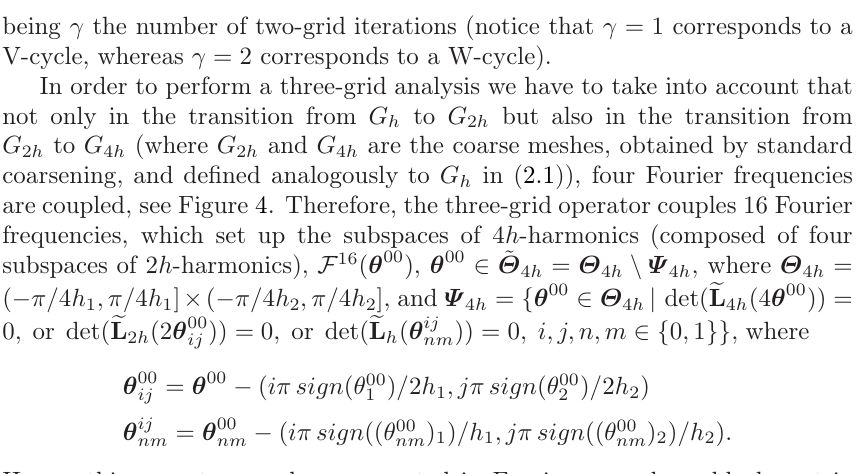
Figure 4. Frequencies coupled by a two-grid and a three-grid iteration, which generate the space of 2h- and 4h- harmonics. coarse-grid correction, and therefore it is especially helpful for problems with difficulties on coarse-grid corrections or when different discretizations are used on coarser grids. The error transformation by a three-grid cycle is given by e m +1 e m , with = M 4 h h h h M 4 h K 4 h S ν 1 L h ) S ν 1 = S ν 2 = S ν 2 ( I h − P h ( I 2 h − ( M 4 h ) γ )( L 2 h ) − 1 R 2 h , h h h 2 h 2 h h h h h is defined as where M 4 h 2 h M 4 h L S ν 1 = S ν 2 ( I 2 h − P 2 h ( L 4 h ) − 1 R 4 h 2 h ) 2 h 4 h 2 h 2 h 2 h